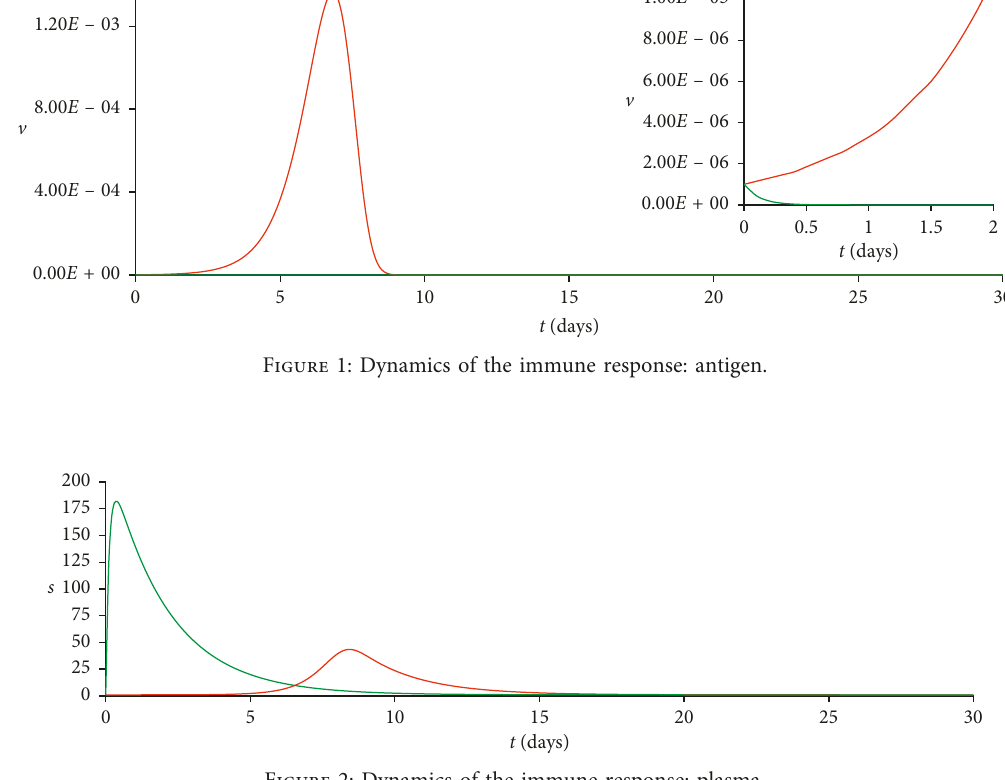
Figure 2: Dynamics of the immune response: plasma.